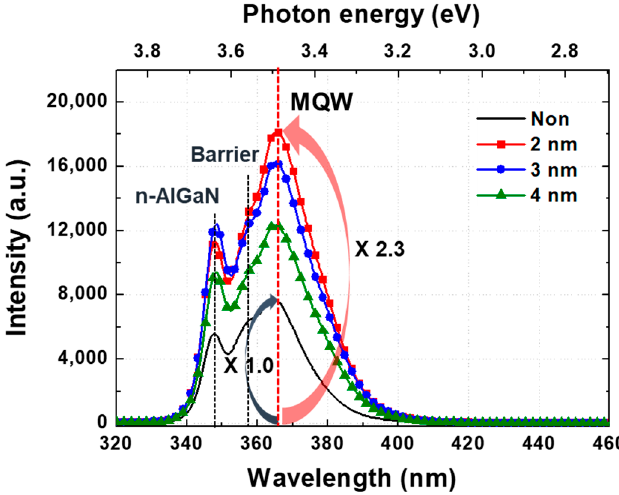
Figure 4. Finite-difference time-domain (FDTD) simulations according to the diameters of Pt NPs in UV emitters. Calculated and experimented absorption and field propagations according to the diameters of Pt NPs ( a , d ) 10 nm, ( b , e ) 20 nm, and ( c , f ) 25 nm, respectively.